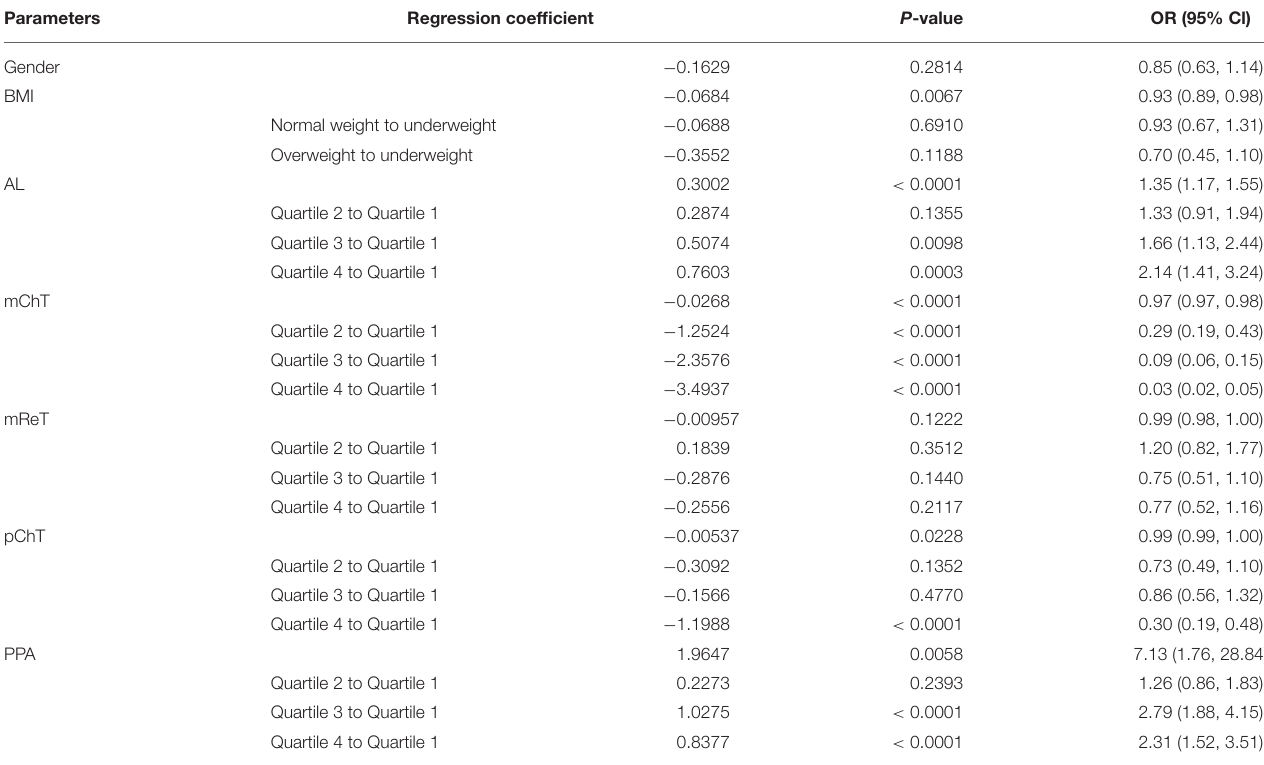
TABLE 5 | Associations of fundus tessellation severity with ocular and systemic parameters. Parameters